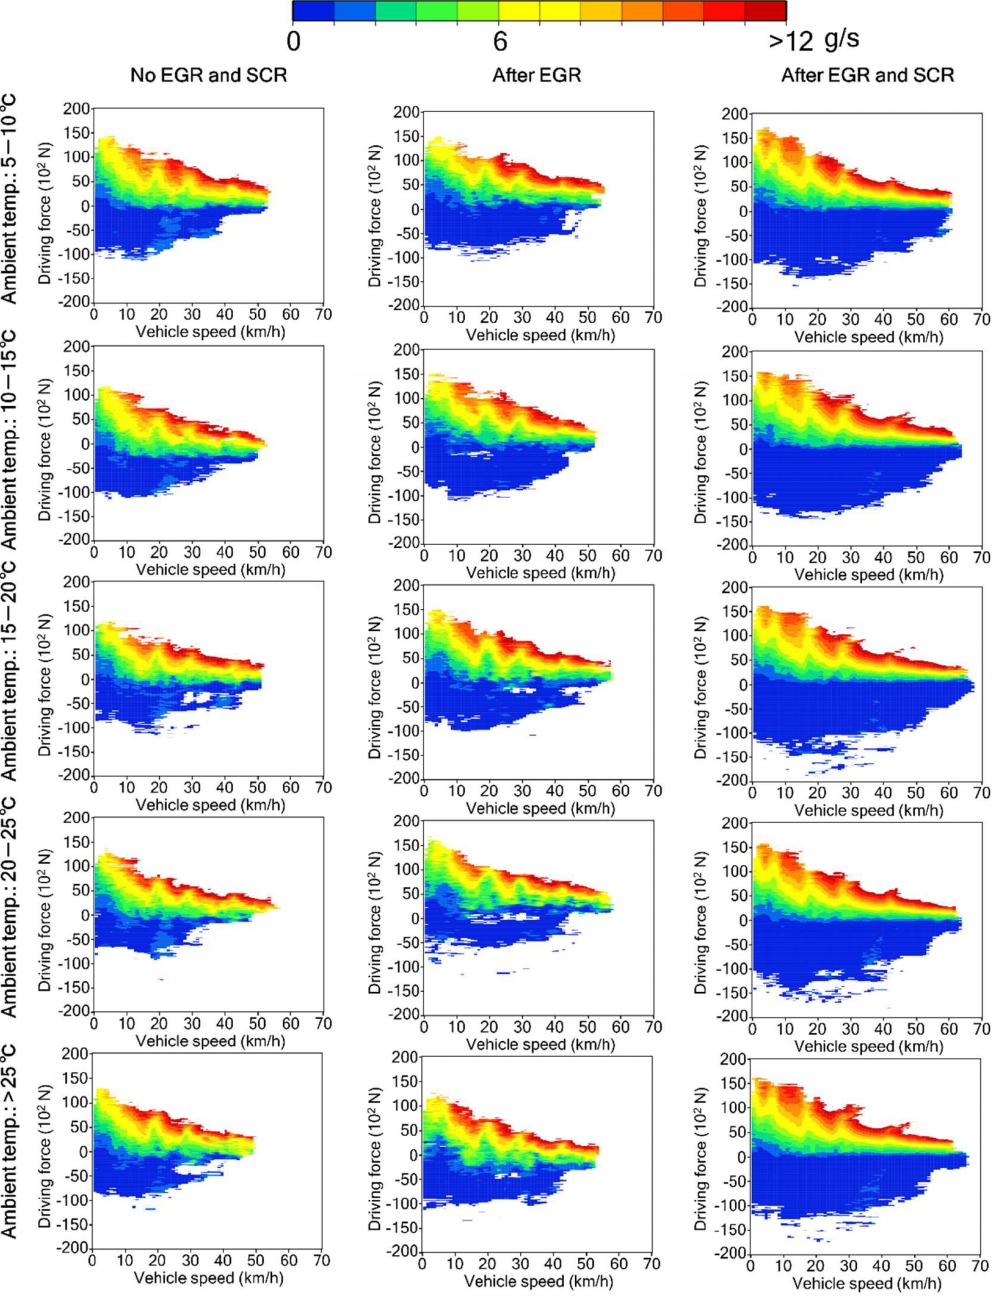
Figure 5. Transient emission map for CO 2 emissions evaluated using a real-world driving emission test conducted using PEMS, as well as the vehicle driving force and speed